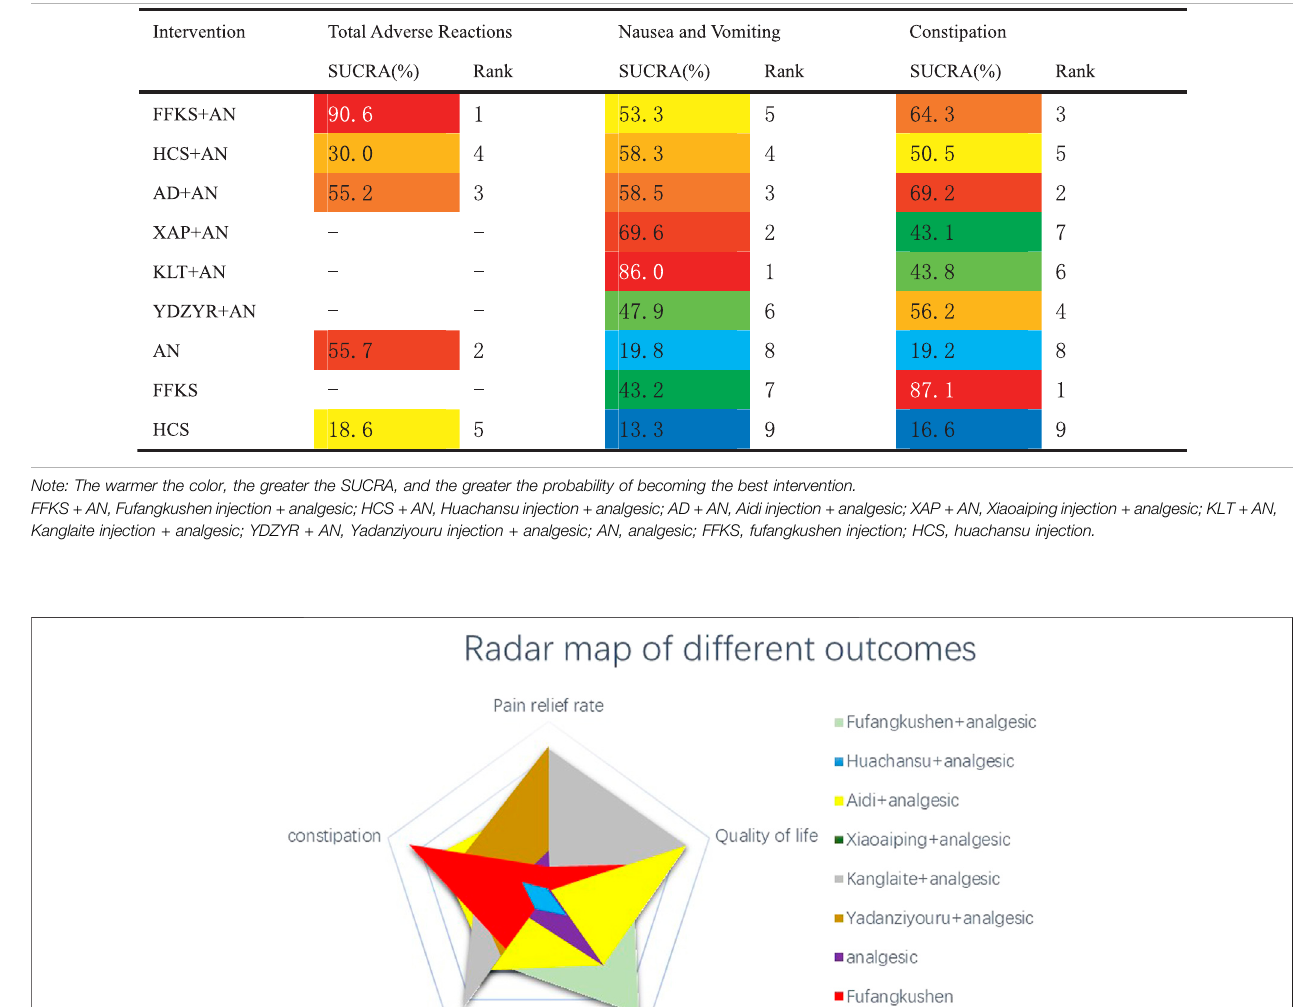
Frontiers in Pharmacology |